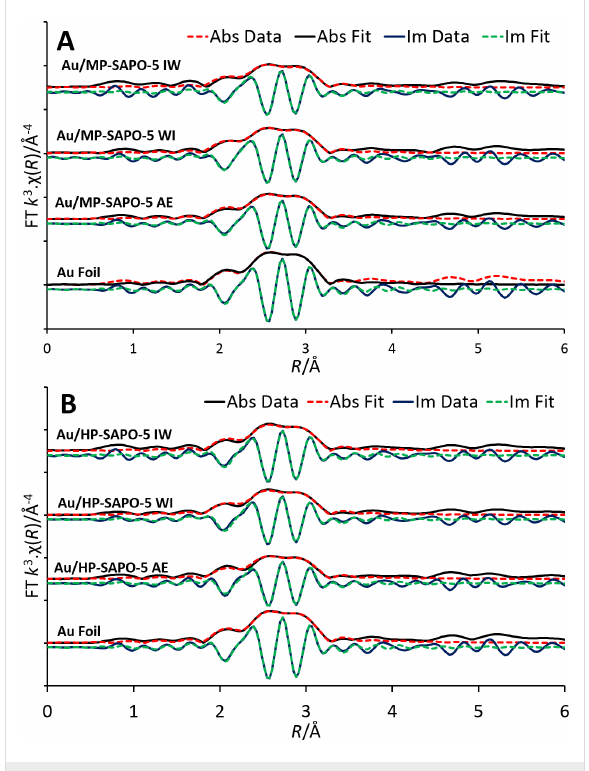
Figure 3: The magnitude and imaginary component of the k 3 -weighted Fourier transform for the XAS data of the Au-deposited microporous MP-SAPO-5 (A) and hierarchical HP-SAPO-5 (B) compared to the Au foil. Associated scattering paths, with a single Au–Au feature are